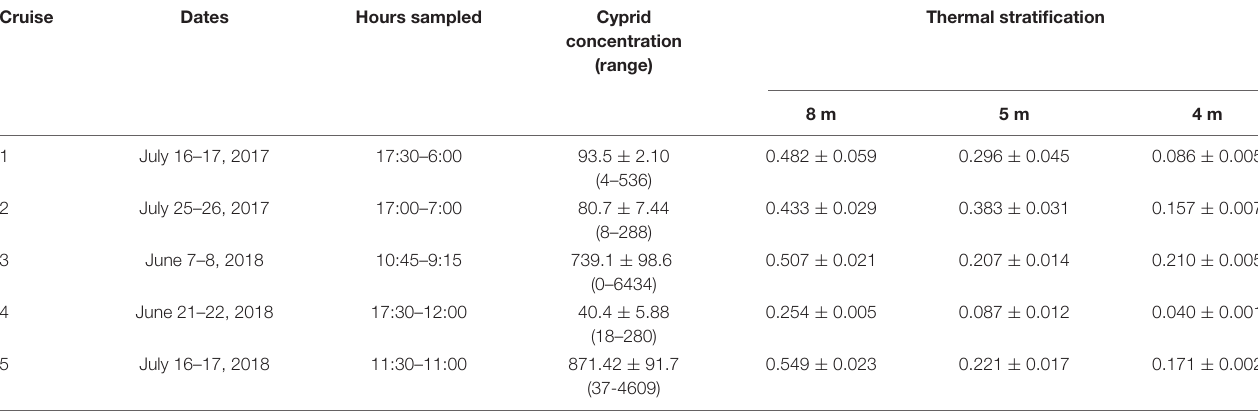
TABLE 1 | Cruise summaries with dates, start and end hours of CTD and plankton sampling (PDT), Chthamalus fissus cyprid concentrations (no. m − 3 ) with minimum and maximum concentrations per cruise in parentheses, and average ± SE thermal stratification ( (cid:49) ◦ C m − 1 ) at 8 m- and 5 m-deep mooring stations (SBE 56 thermistor data) and 4 m-deep plankton station (CTD